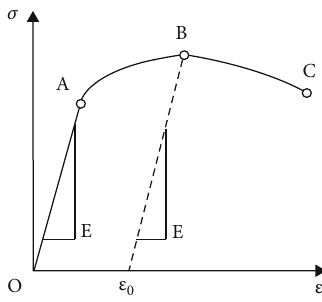
Figure 2: Characteristic stress-strain behaviour of the 15-5PH stainless